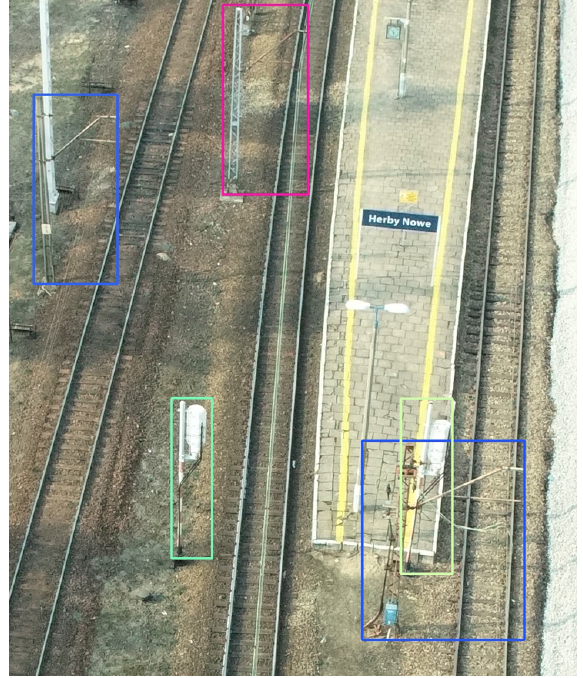
Figure 8. The final result is an example of training dataset for traction pole detection. ISPRS Int. J. Geo-Inf. 2022 , 11 , x FOR PEER REVIEW